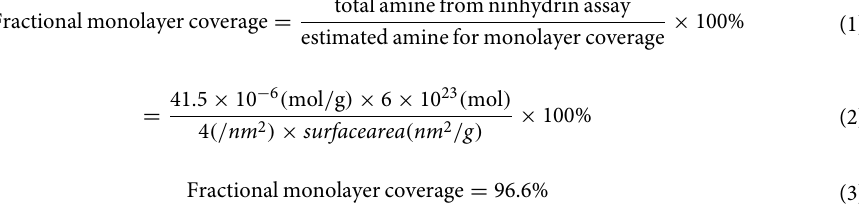
Fig. 2a–d, respectively. The strong absorption peak at 589 cm −1 assigned to Fe–O stretching vibrations from iron oxide can be observed for MNS, MNS-APTES, and MNS-APTES-NTD 57 . Additionally, the spectrum in Fig. 2b may contain a stretching vibration of Fe–O–Si at 589 cm −1 overlaying with Fe–O vibrations from iron oxide 50 . The peak corresponding to Si–O–Si at 1015 cm −1 , and the bending and stretching vibrational modes of NH at 1637 cm −1 and 3400 cm −1 , respectively, confirm the coverage of silane with a free amine group of APTES on the MNS surface 58,59 . A band observed at 2920 cm −1 is due to C-H stretching vibrations of the anchored propyl group 60,61 . The TEM–EDX spectra (see Fig. S2 in supplementary information) of the APTES modified MNS also shows the presence of silicon (Si) confirming the APTES coverage on the surface of MNS. APTES coverage on the MNS surface provides functional amino groups for drug conjugation. The conjugation of NTD